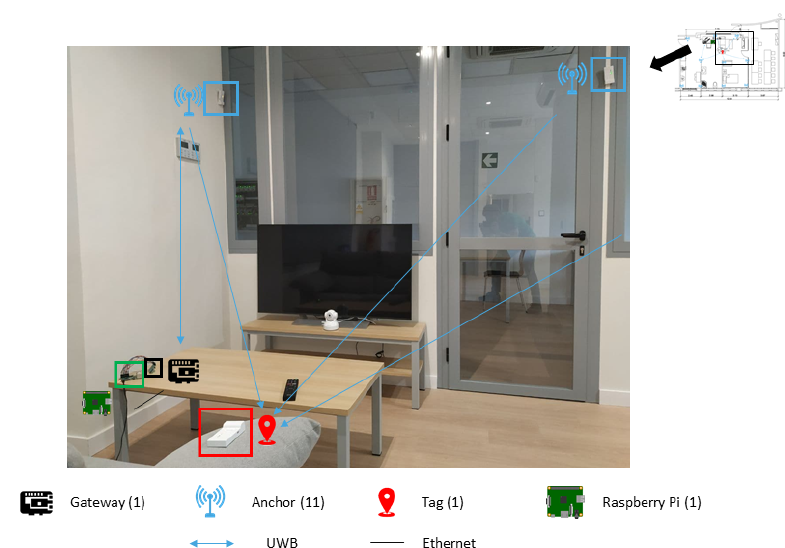
Figure 12. Roles in a Real Time Location System (RTLS) network.